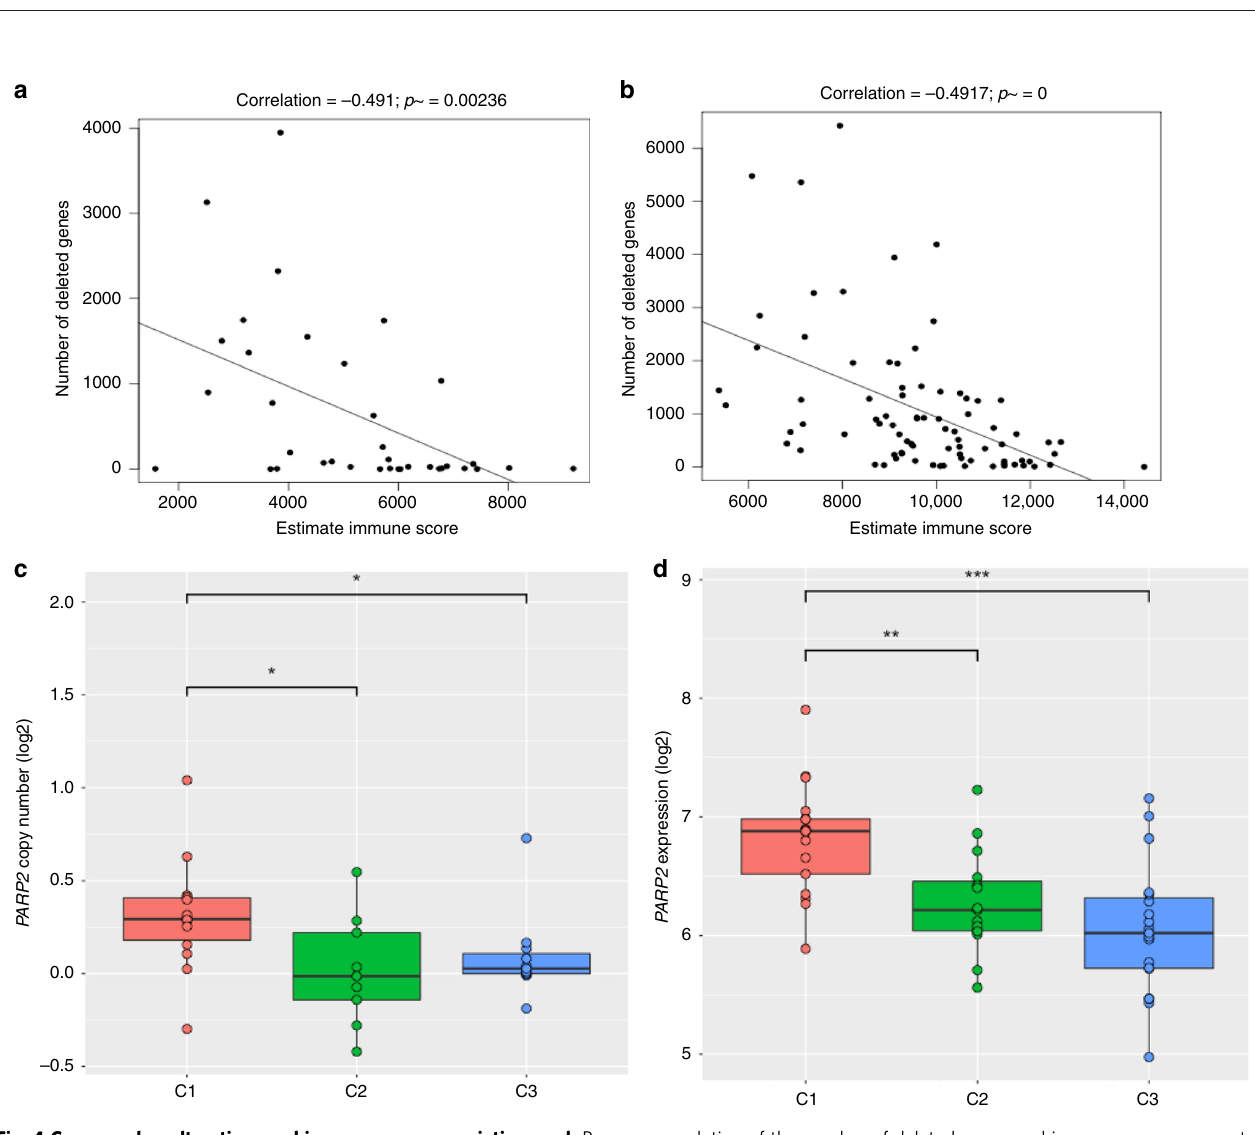
Fig. 3 Immune pro fi ling. a ESTIMATE immune scores in TCGA tumor types, our OS cohort (MDACC.OS), the OS cohort from ICGC (BOCA-UK.OS), the OS cohort from TARGET (TARGET.OS), and from four patients who underwent combination CTLA-4 blockade and PD-L1 blockade but exhibited no objective responses (Immunotherapy.OS). Note that TCGA-THYM is derived from the thymus made up mostly of lymphocytes and would have in fl ated scores. b . Unsupervised hierarchical clustering based on ssGSEA enrichment scores of each immune gene list from Charoentong et al. The three predominant clusters are referred to as “ C1 ” and “ C2 ” , and “ C3 ” immune in fi ltrate groups. c Boxplot of the ESTIMATE immune scores of samples across the three immune clusters C1, C2, and C3. The signi fi cances of the comparisons were from the Wilcoxon rank sum test are shown in asterisks. d The geometric mean expression of GZMA and PRF1 genes (cytolytic score) shown as a boxplot across the three immune clusters C1, C2, and C3. The signi fi cances of the comparisons were from the Wilcoxon rank sum test. e Immunosuppressive pathways that are signi fi cantly deregulated between immune clusters C1 and C3. The signi fi cance (FDR) of deregulation were from the GSEA analysis. f Fold change and signi fi cance of expression difference between C1 and C3 for key genes from pathways in e : CD274 (PD-L1), CTLA4 , IDO1 , IFNG , IFNGR1 , and IL6 (these genes were not present in the gene lists used to de fi ne these immune groups). The linear mode in the limma R package was used to determine signi fi cance.